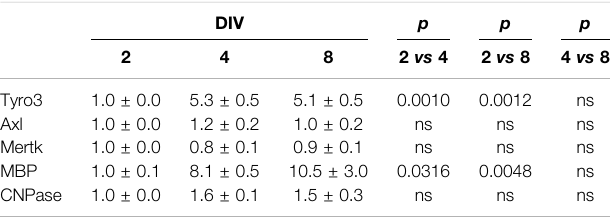
TABLE 1 | Gene expression of TAM receptors (Tyro3, Axl, Mertk) and MBP and CNPase in oligodendrocyte precursors at different days in vitro (DIV).